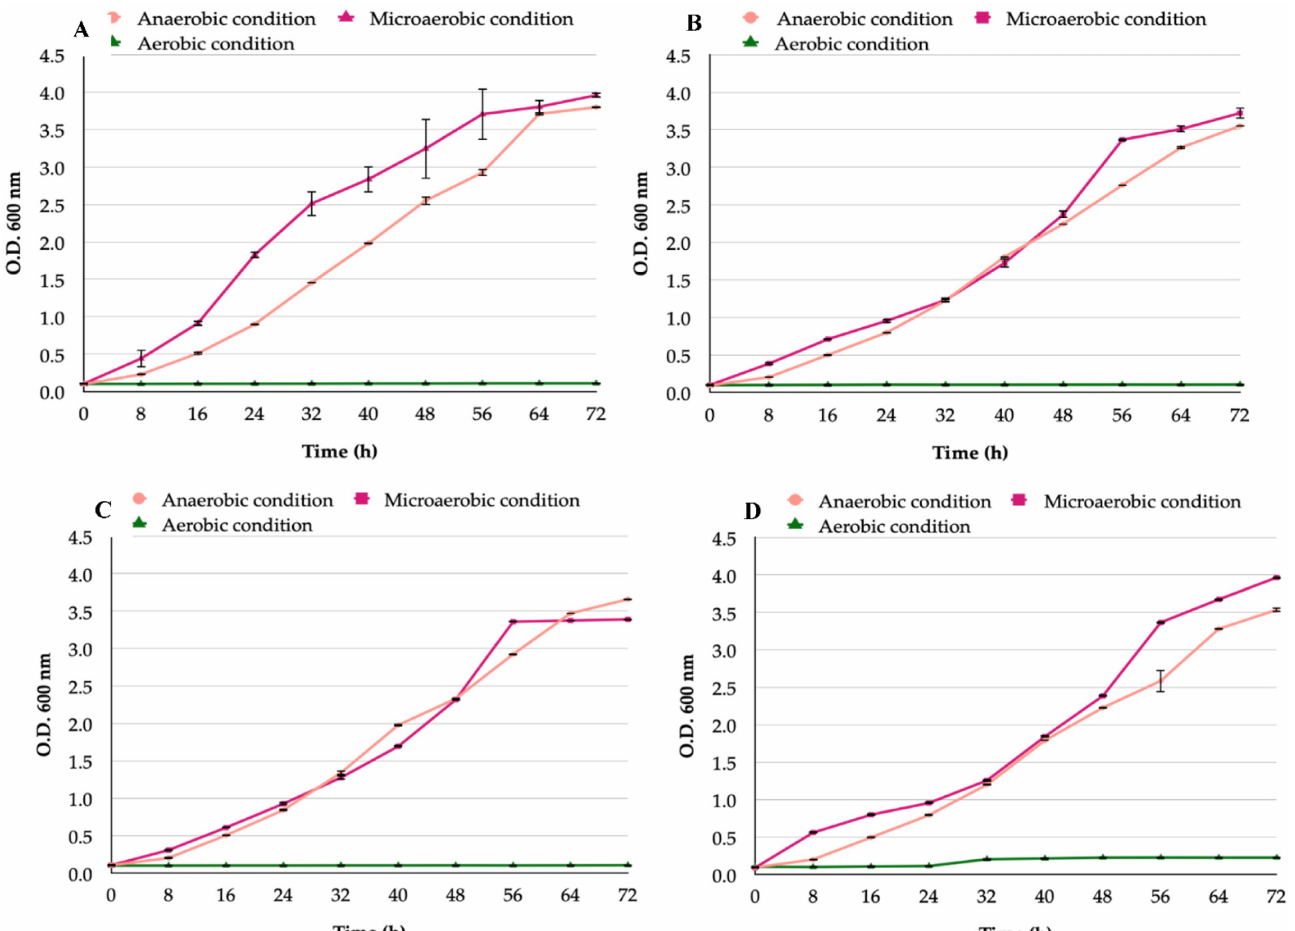
Figure 1. Growth curves of H. pylori strains incubated in the presence of an aerobic, microaerobic, or anaerobic condition: ( A ) H. pylori reference strain J99; ( B ) H. pylori reference strain G-27; ( C ) H. pylori SS-1 reference strain; ( D ) H. pylori H707 clinical